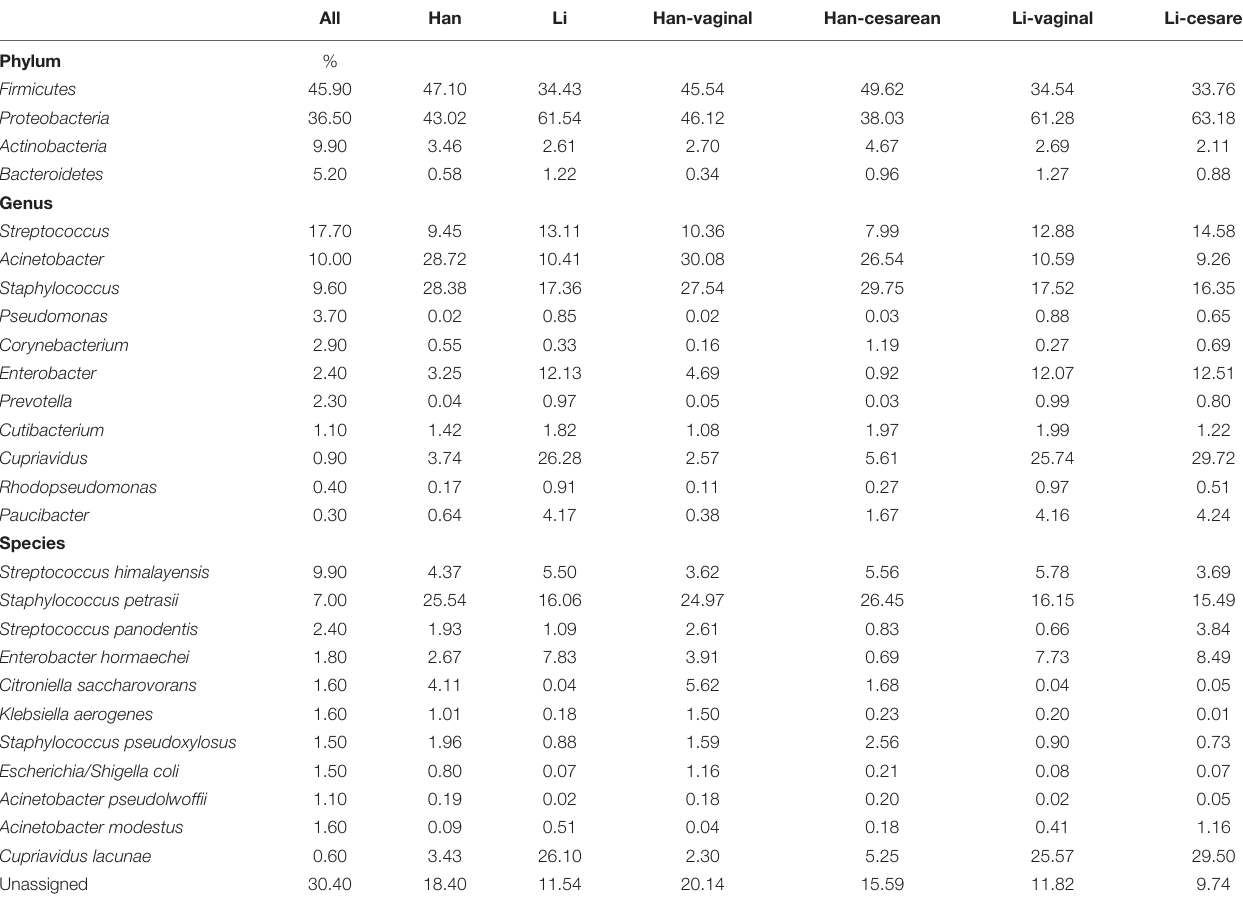
TABLE 3 | Associations between maternal characteristics and top 4 phyla, 11 genera, and 11 species. All Han